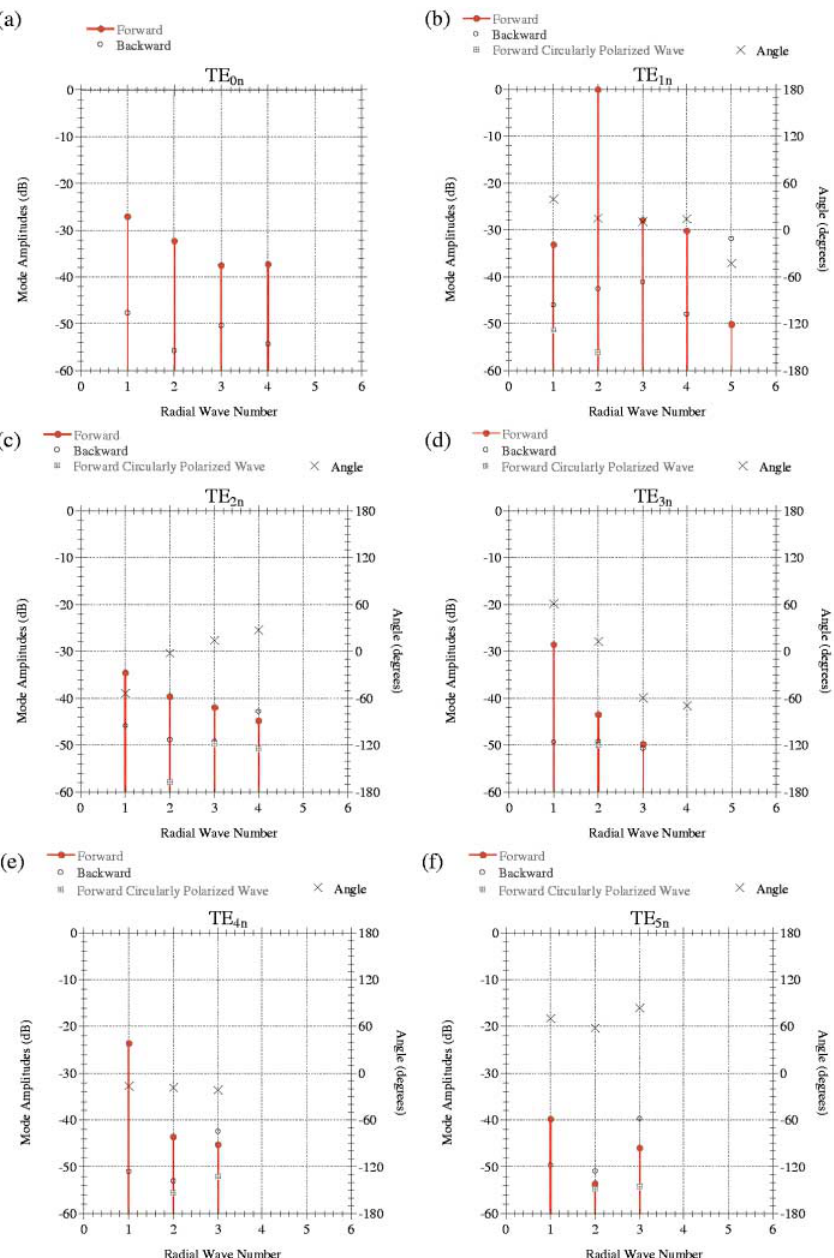
FIG. 22. (Color) The mode spectrum after the transport line when the injected signal is the TE 12